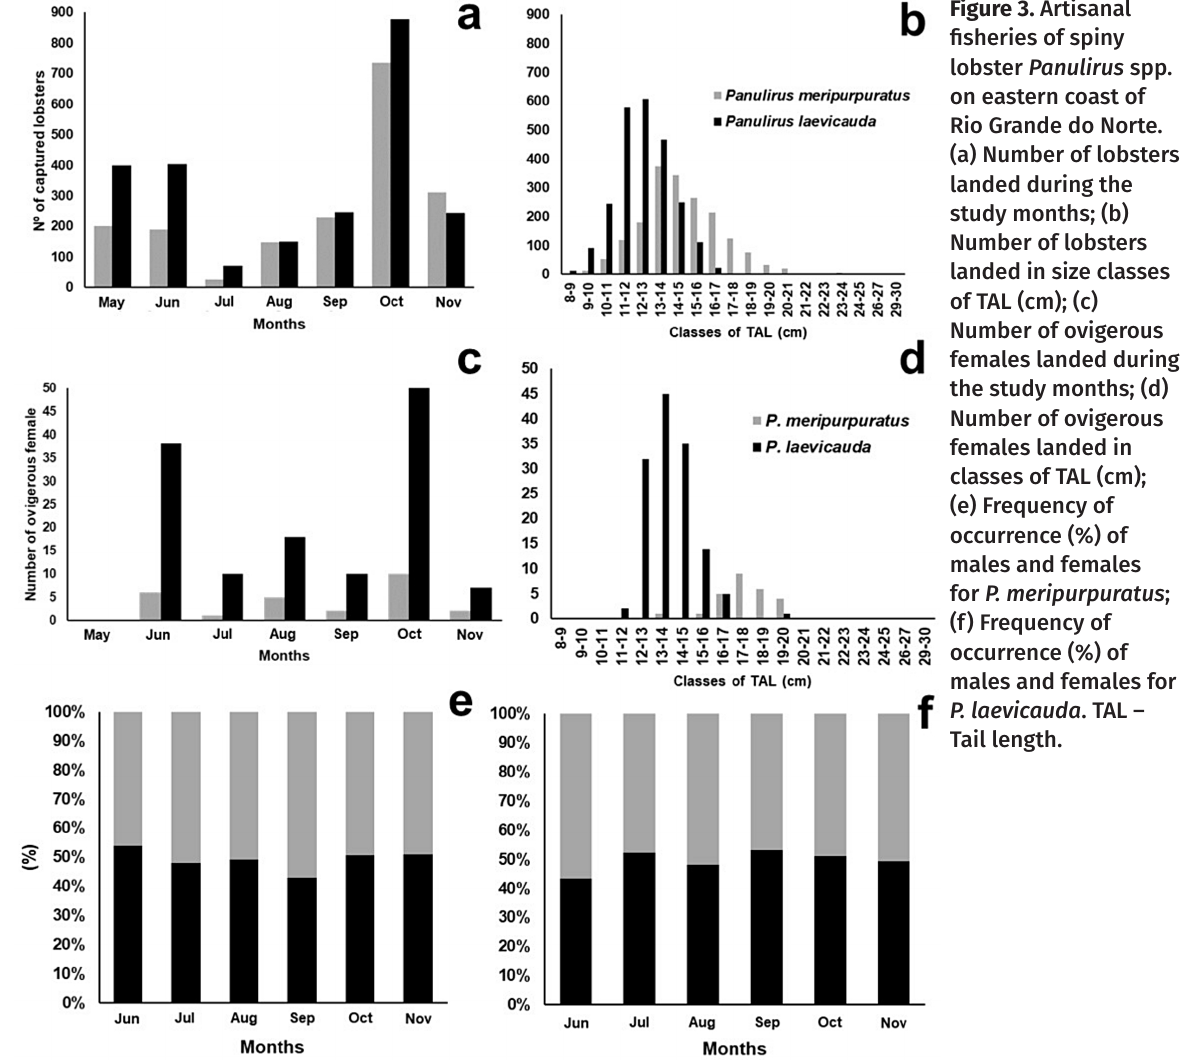
Figure 3. Artisanal fisheries of spiny lobster Panulirus